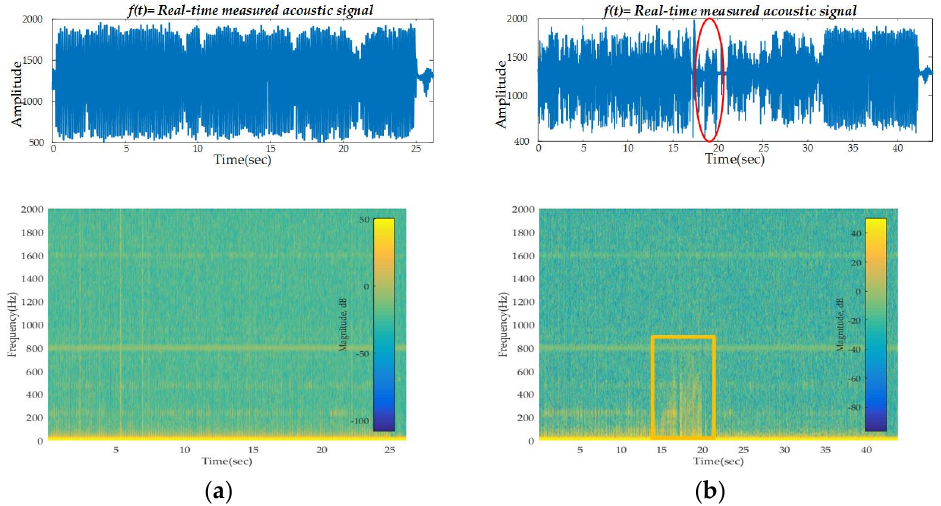
Figure 7. STFT of measured data comprised of background noise and pipeline environment with ( a ) no leakage ( b ) leakage (6 mm